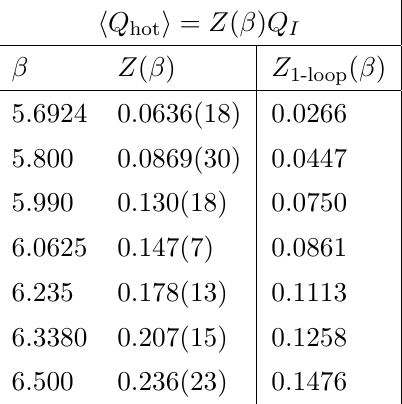
Table 21 . Multiplicative renormalisation factor, Z ( β ) , relating the average lattice topological charge, Q hot , calculated on the rough Monte Carlo fields and the integer valued topological charge Q I calculated after 20 ‘cooling’ sweeps of those fields. Also the 1-loop perturbative prediction. At the values of β shown.